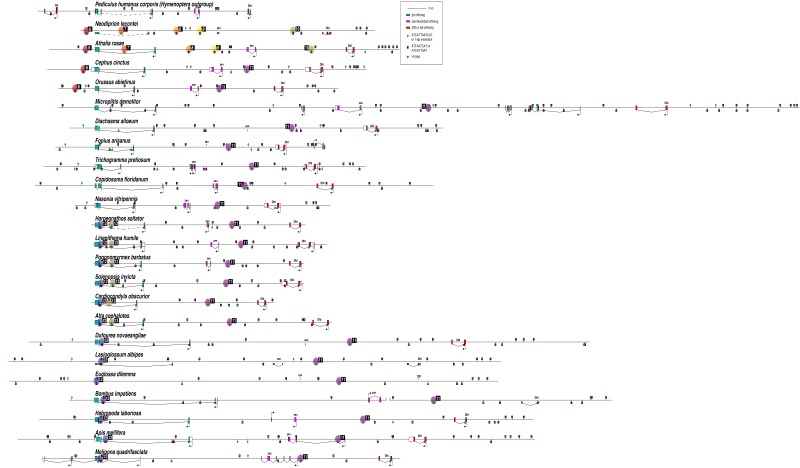
Conservation of several motifs (6-13) within Hymenoptera.